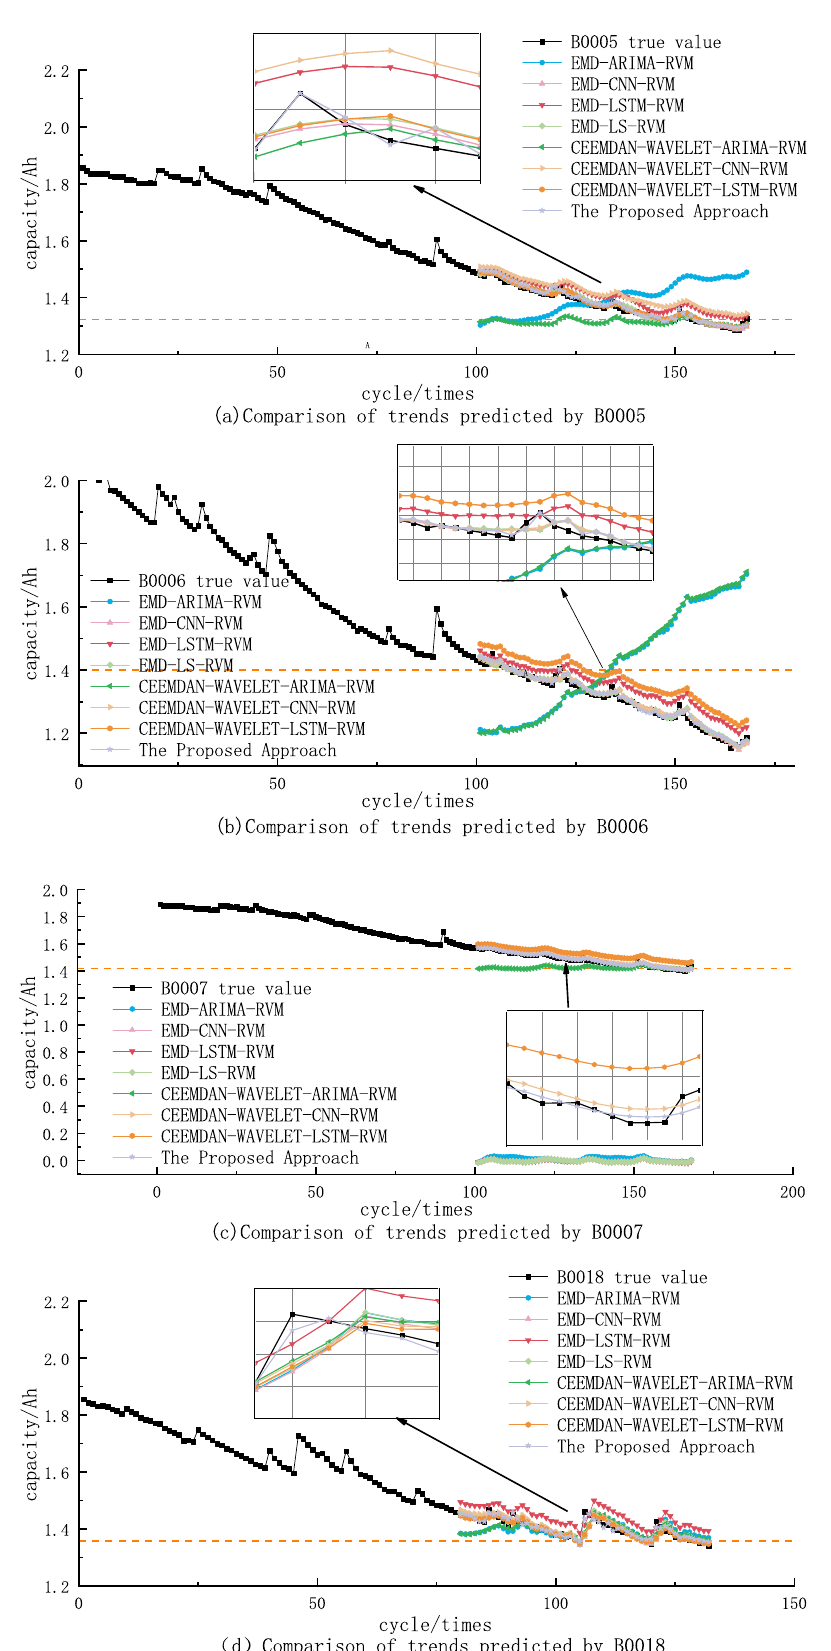
Figure 9. Comparison of the proposed approach with other common prediction